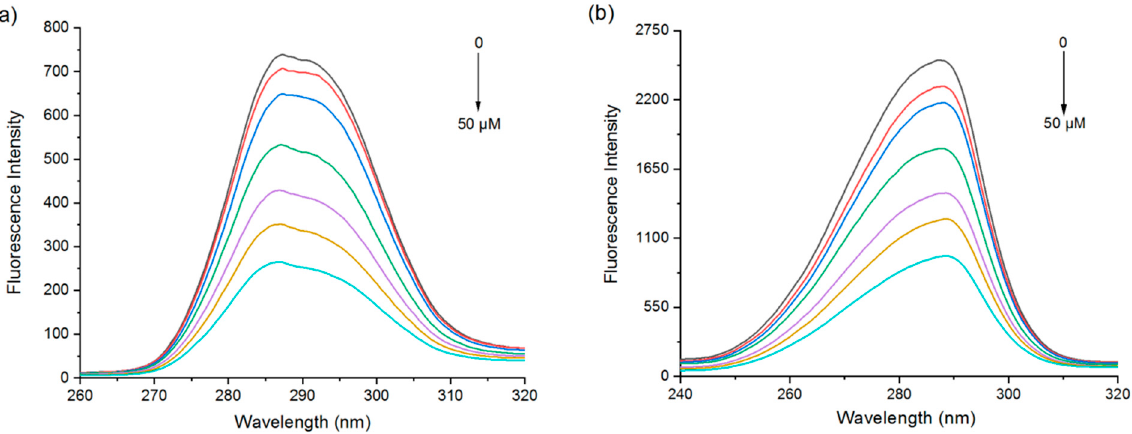
EGCG Figure 2. Synchronous fluorescence spectra of PPI at Δλ = 15 nm ( a ) and Δλ = 60 nm ( b ) with differ- ent EGCG concentrations.